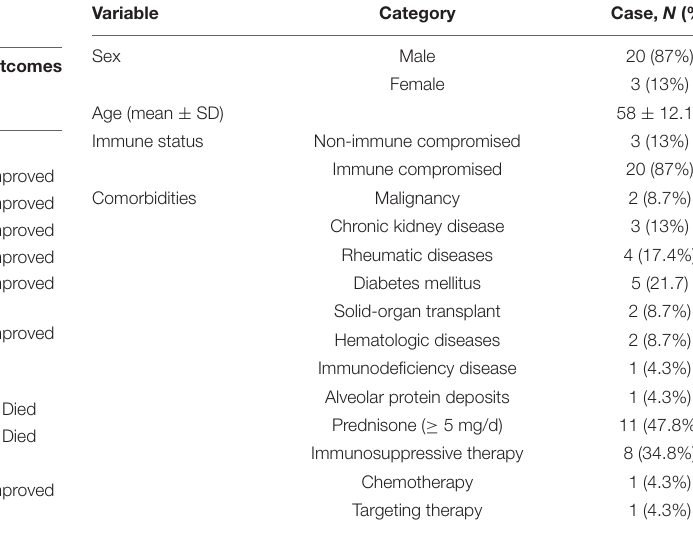
TABLE 1 | Summary of antimicrobial susceptibility results of Nocardia. Antimicrobial agents